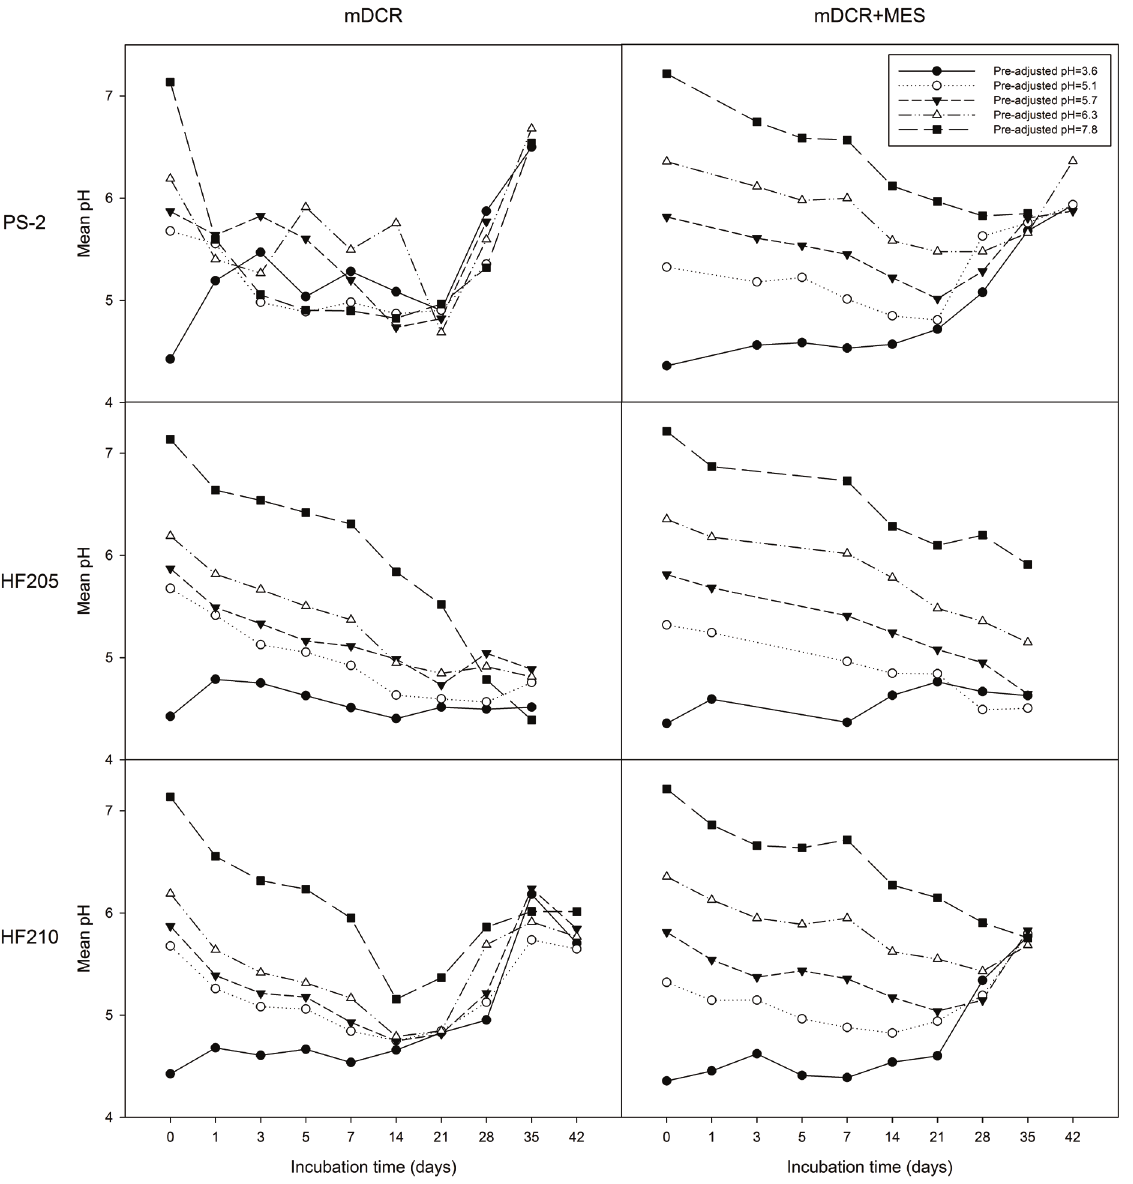
Figure 2. Medium pH changes over incubation times from three genotypes in mDCR and mDCR+MES media. Genotypes included one mature genotype, PS-2 and two juvenile genotypes, HF205 and HF210. After surface sterilization and dissection, inner vegetative buds from above three genotypes were placed on either mDCR or mDCR+MES medium for incubation up to 42 days. These buds were incubated in a growth chamber at 25 ° C with light regime adjusted to 16-hour light followed by 8-hour darkness each day. Medium pH was recorded using a pH meter when sample reached each incubation requirement where five pH values were recorded within each petri dish. Data points represent mean pH. Please see Dataset 2 and Dataset 3 for the raw